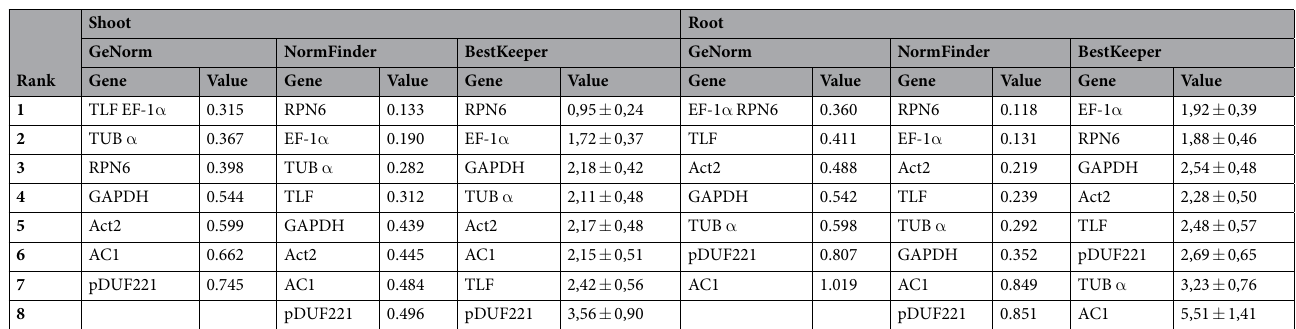
Table 5. Stability ranking of each candidate reference gene using different algorithms under heat shock stress treatment in shoot and root. Column “value” corresponds to M in geNorm, S in NormFinder and CV ± SD in